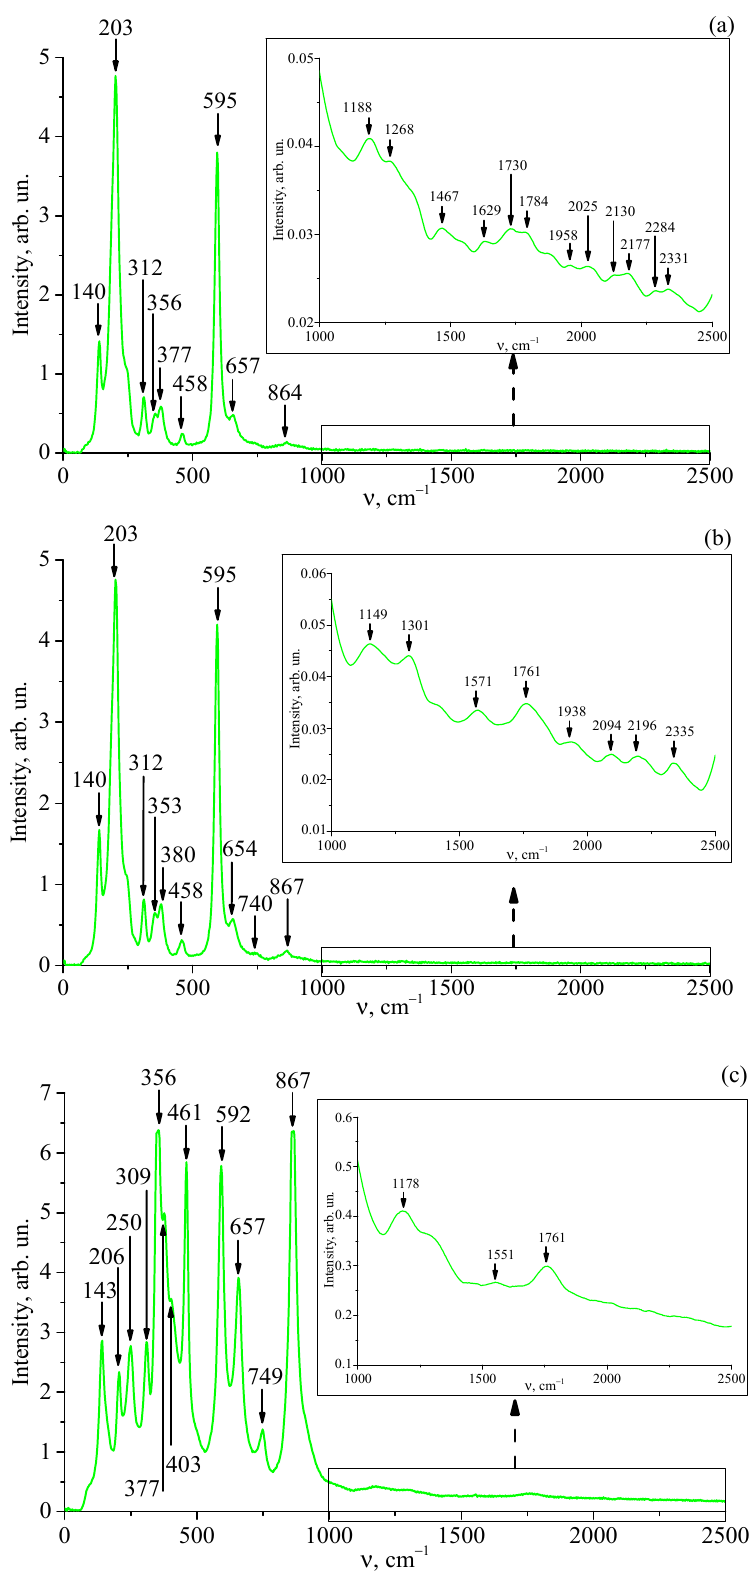
Figure 2. Raman spectra excited by λ 0 = 532 nm radiation in the LT:Cr crystal in x ( zz,zy ) x ( a ),